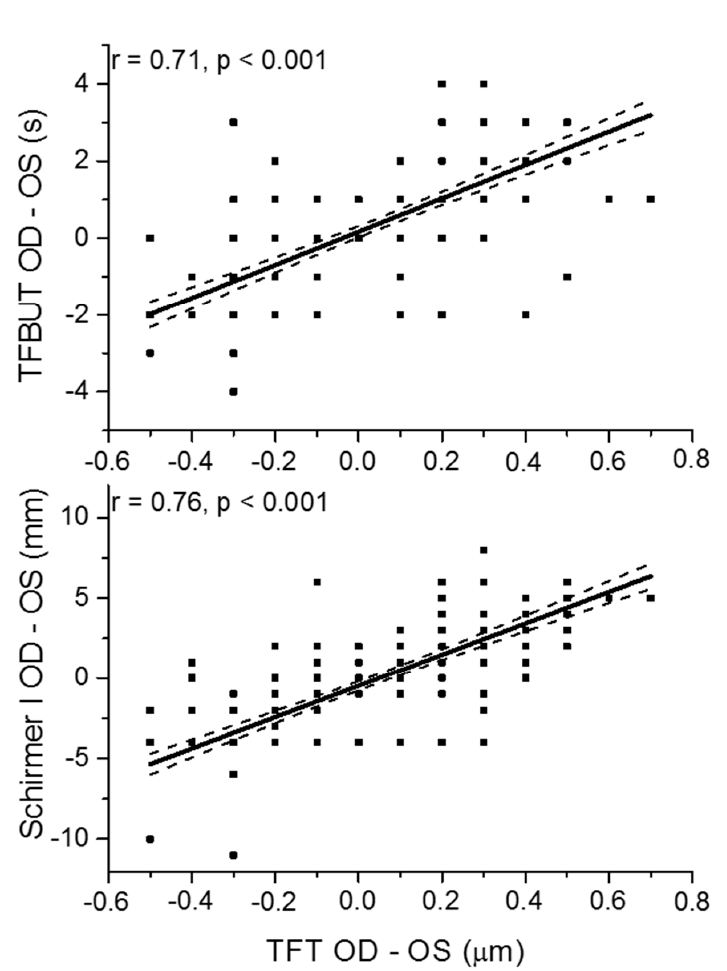
Figure 3. Correlation between inter-eye difference in Tear Film Thickness (TFT OD-OS) and inter-eye difference Tear Film Break Up Time (TFBUT OD-OS) and inter-eye difference Schirmer I test (Schirmer I OD-OS; n = 225). The regression line (solid red) and the 95% confidence interval are shown (dashed red).